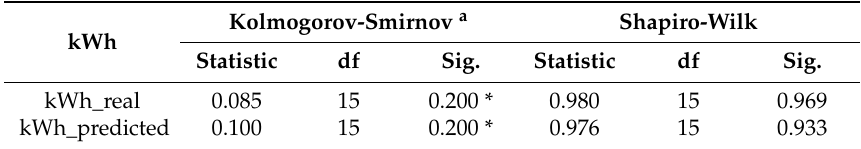
Table 9. Test of normality for real and predicted consumption D3 building.